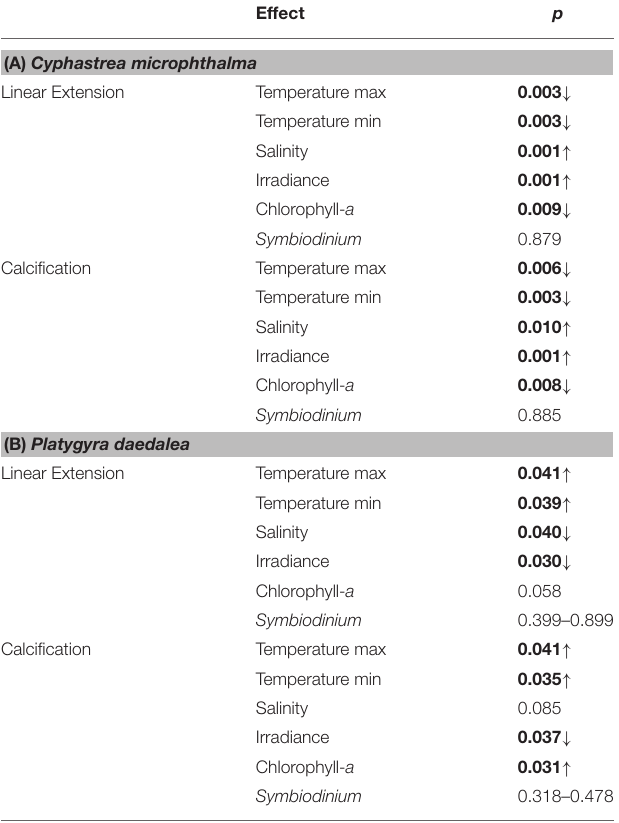
TABLE 3 | Summaries of environmental effects on linear extension and calcification for (A) Cyphastrea microphthalma and (B) Platygyra daedalea in the Persian Gulf.